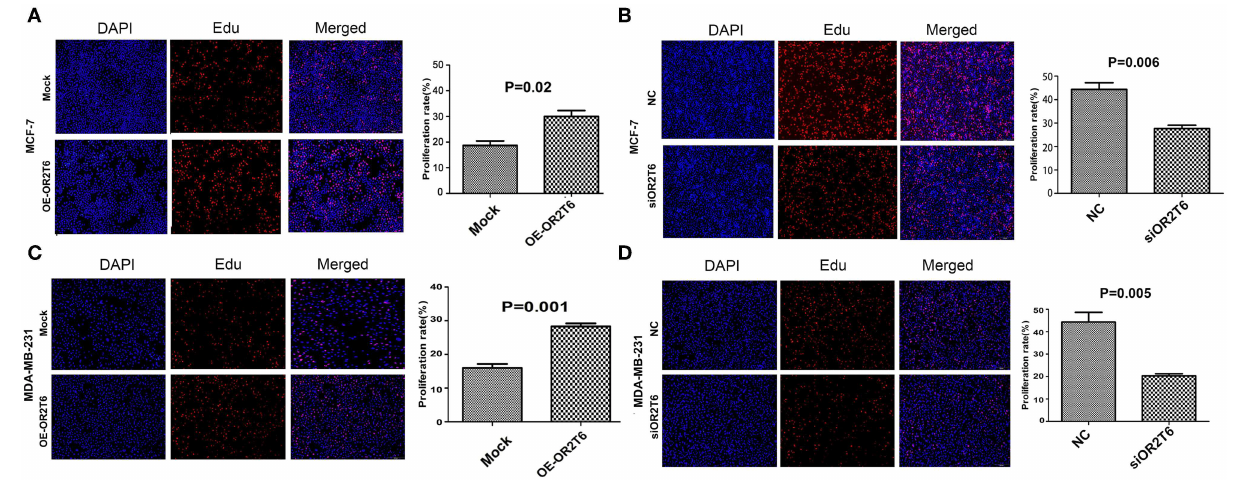
FIGURE 2 | OR2T6 promotes the proliferation of breast cancer cell lines MCF-7 and MDA-MB-231. The percentage of EdU positive cells was recorded as the proliferation rate. Student’s t -test showed that the proliferation rate was increased significantly when OR2T6 was over-expressed in breast cancer cells ( A,C ), and reduced dramatically when OR2T6 was knocked down (B,D) . Results were representative of triplicate experiments. “Mock” and “OE-OR2T6” stand for the cells transfected with pcDNA3.1 vector and pcDNA3.1-OR2T6 plasmid, respectively. “NC” and “siOR2T6” stand for the cells transfected with negative control siRNA and specific siRNA targeting the OR2T6 gene,